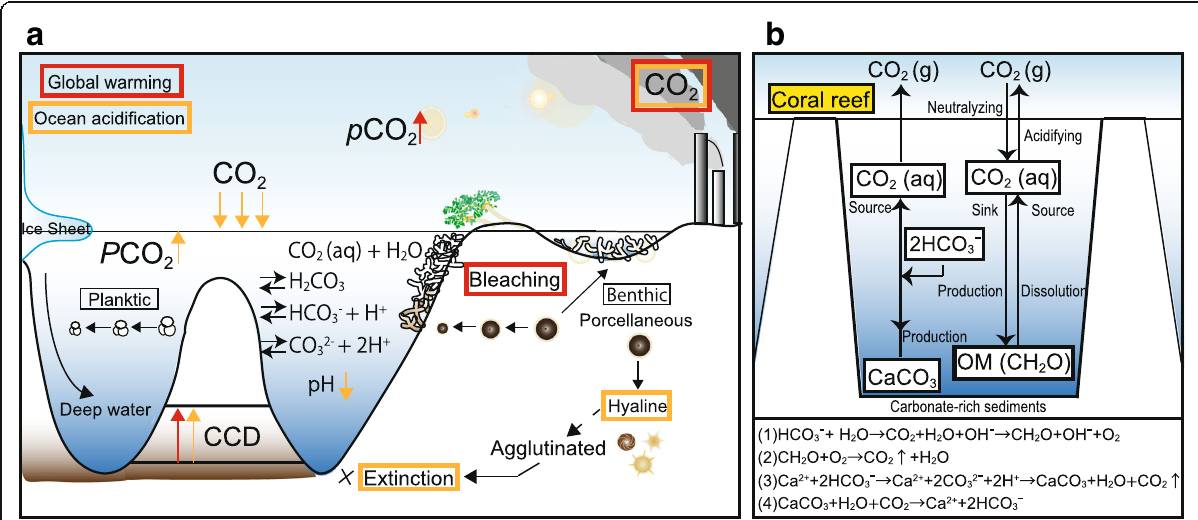
Fig. 1 a Schematic diagram of modern carbon cycle for both global warming and ocean acidification, which are often referred to as the “ evil twins ” of climate change. The increase in atmospheric CO 2 concentration caused by human activities is predicted to promote global warming by ~ 2.5 °C and an ocean pH reduction of ~ 0.3 by 2100 AD. Coral reefs are among the ecosystems most vulnerable to environmental stresses (bleaching and/or ocean acidification). An aragonite saturation state of 3.3 is suggested to be the environmental limit for the existence of tropical coral reefs where calcification exceeds the dissolution of calcium carbonate (Kleypas et al. 2006). The culture experiments reported general negative effects on survival, calcification, growth, and reproduction despite significant variation among taxonomic groups in marine environments. For example, calcification tended to decrease versus p CO 2 in both aposymbiotic and symbiotic polyps of Acropora digitifera , although its coral calcification of adult branches was not reduced so much under higher p CO 2 conditions. In contrast to the majority of benthic foraminifers dwelling in coral reefs, Calcarina gaudichaudii showed a positive response to increases in p CO 2 . Since CO 2 is more soluble in lower temperature seawater, ocean acidification is more critical in the polar and high-latitude regions. Surface water in the Southern Ocean will be undersaturated with respect to aragonite by 2050 AD (Orr et al. 2005). More severe dissolution of carbonate will occur in deep-sea due to the increase in solubility at higher pressure, which will make the CCD shallow. Most likely, deep-sea benthic foraminifera will be forced to change from calcareous to the agglutinated forms reported at the Paleocene/Eocene boundary. b Schematic diagram of the carbon cycle in coral reefs. The equations involve the following important processes: (1) photosynthesis (CO 2 invasion, resulting in slowing acidification), (2) respiration/degradation (CO 2 evasion, promoting acidification), (3) calcification (CO 2 evasion), and (4) dissolution of carbonate (CO 2 invasion, one of the neutralizing processes). Processes (1) and (2) are associated with organic carbon metabolism, whereas (3) and (4) are associated with inorganic carbon processes. Photosynthesis triggers the production of OH − , commonly resulting in the deposition of carbonate. In contrast, the reaction of carbonate with CO 2 works as a sink of CO 2 . This reaction is often promoted in deep-sea, which results in the depletion of carbonate on abyssal plains in the